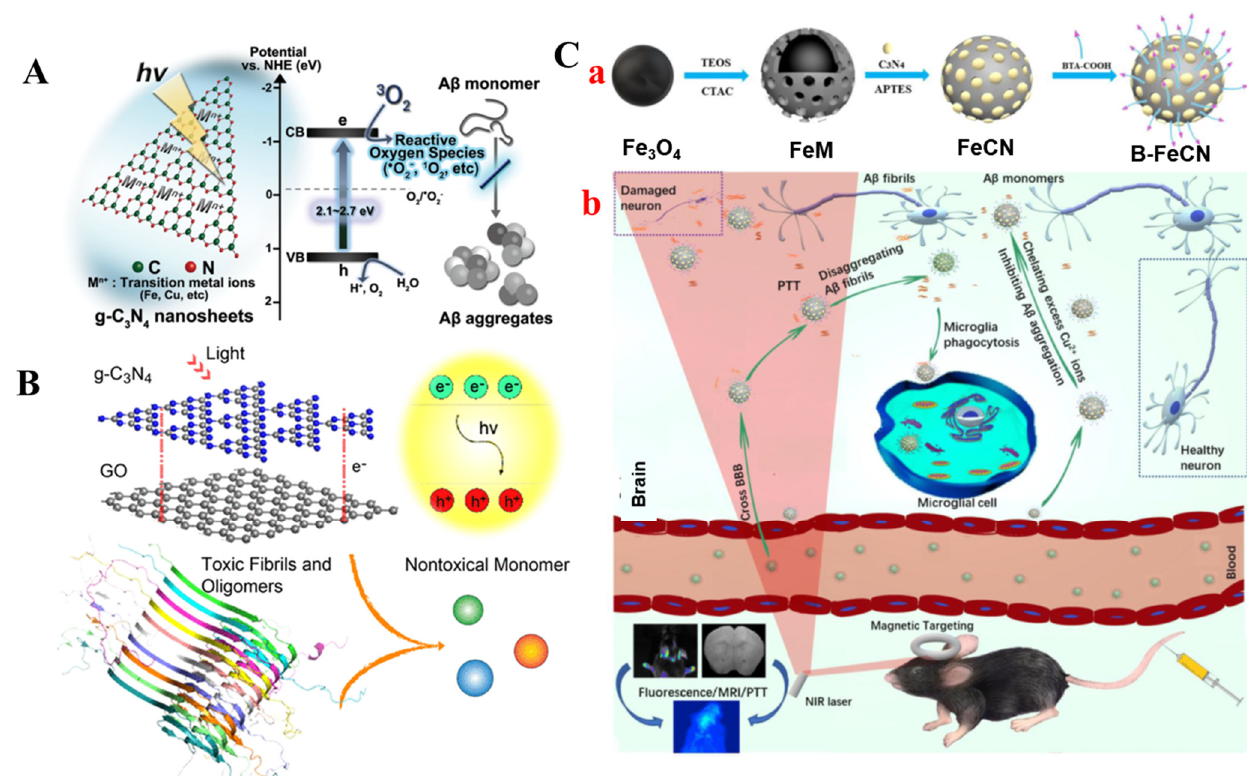
Figure 12. ( A ) Schematic illustration of g-C 3 N 4 NSs as an A β aggregation inhibitor. Reprinted with permission from reference [154]. Copyright 2016 Wiley-VCH. ( B ) Schematic illustration of the degradation of A β aggregates using GO/g-C 3 N 4 under light irradiation. Reprinted with permission from reference [155]. Copyright 2019 American Chemical Society. ( C ) (a) Schematic illustration of the preparation of B-FeCN nanocaptors. (b) Schematic illustration of the B-FeCN nanosystem as a multifunctional nanocaptor to inhibit A β aggregation for the magnetic targeting phototherapy of AD treatment. Reprinted with permission from reference [159]. Copyright 2021 Elsevier.